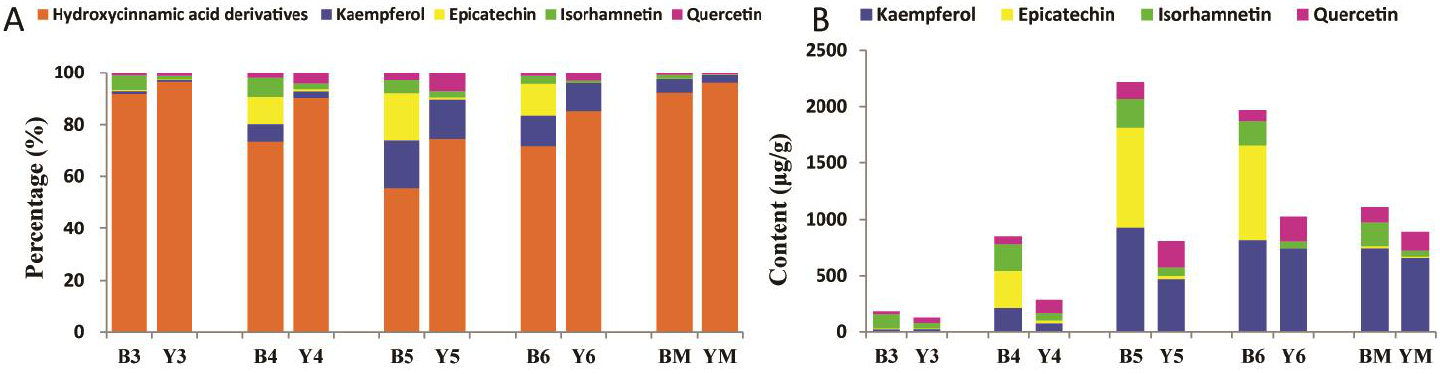
Figure 7. Time-course accumulation pattern of main phenolic components in developing seeds of yellow- and black-seeded B. napus . ( A ) Percentage of phenolic components; ( B ) Content of flavonoids.